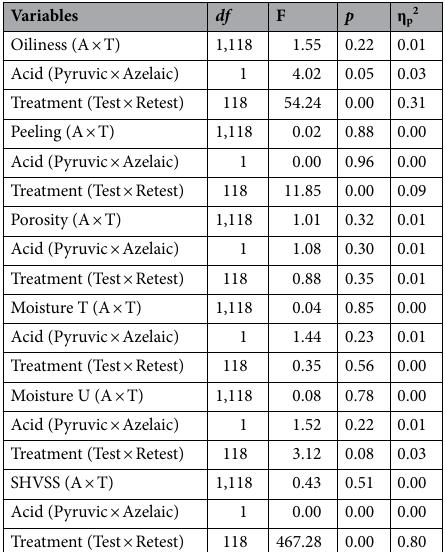
Table 2. Results of one-way ANOVA with repeated measures before and after treatment using one of the two types of acid: pyruvic or azelaic.